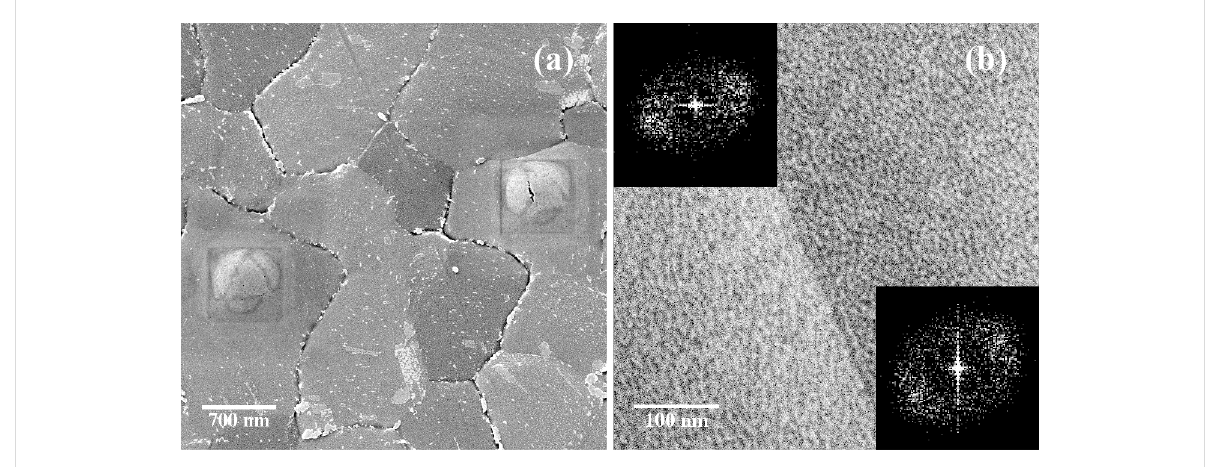
Figure 3: (a) Two blisters created by the 35 keV He + beam on grains with different azimuthal orientation. FOV is 4 μ m. (b) HIM SE image of a Au{111} textured polycrystalline film. The insets are 2D FFTs to demonstrate the relation of the patterns to the orientation of the two grains. He + beam energy is 35 keV. FOV is 500 nm.